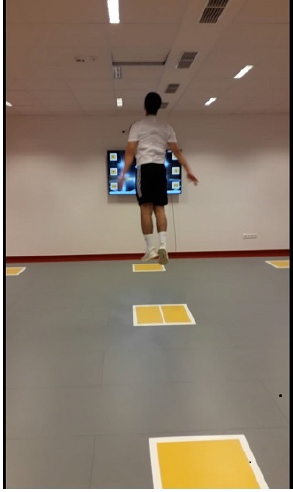
Figure 4. Countermovement Jump